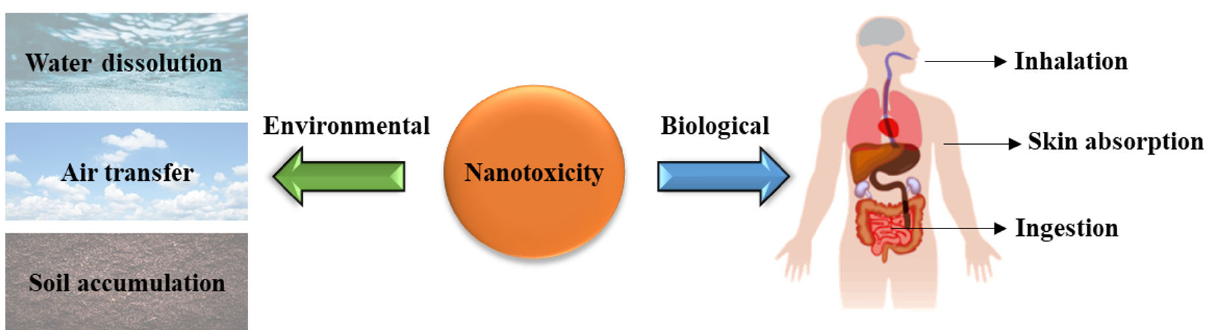
Figure 1. Nanotoxicity exposures for environmental and biological